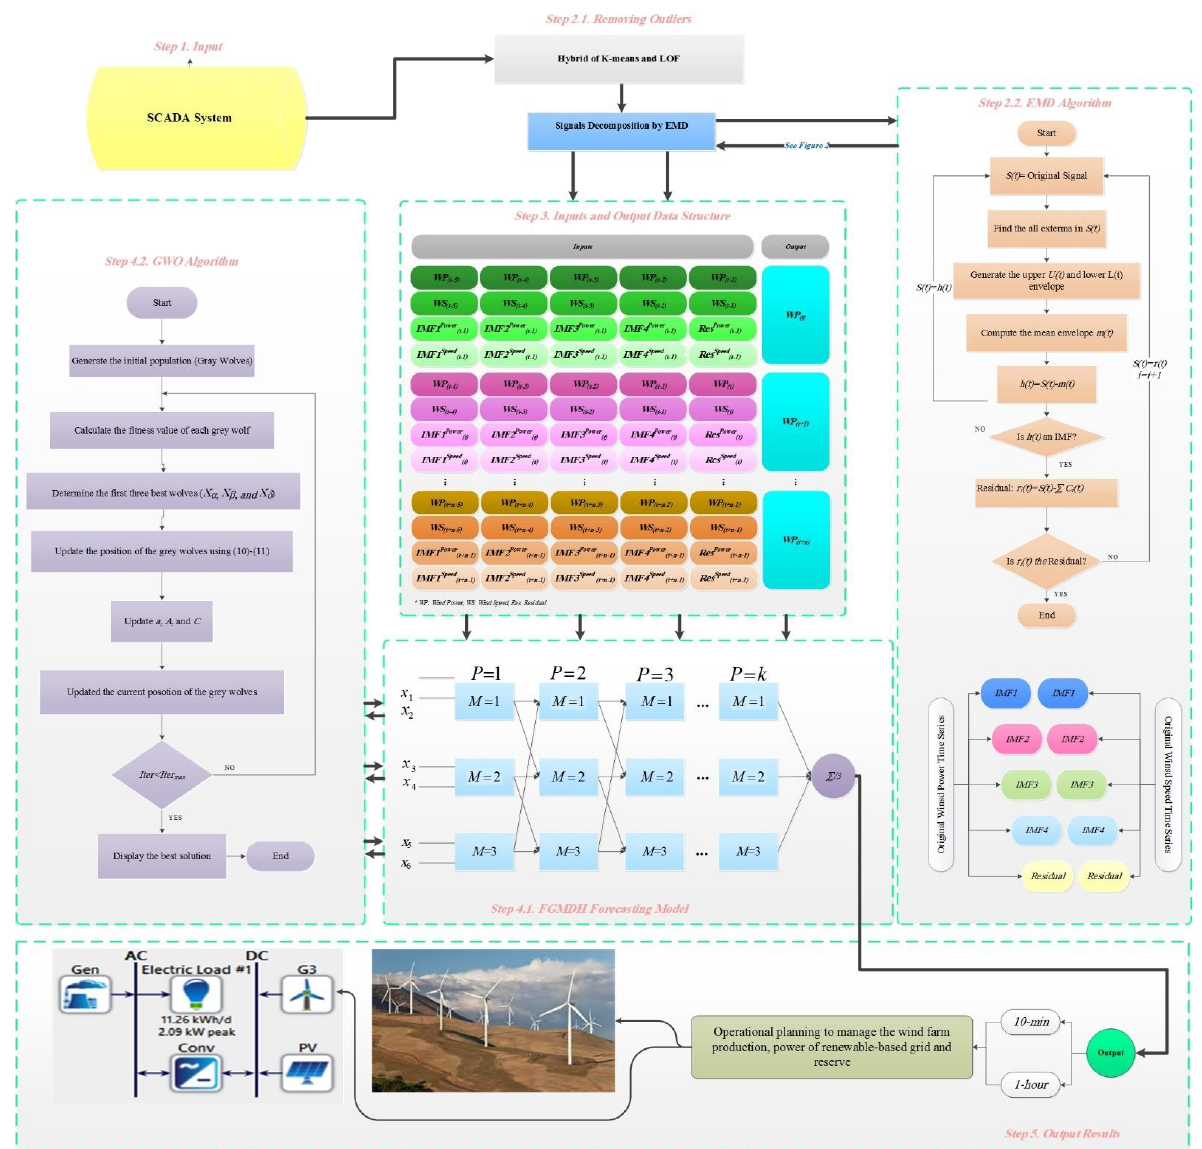
Figure 3. The framework of the proposed model.